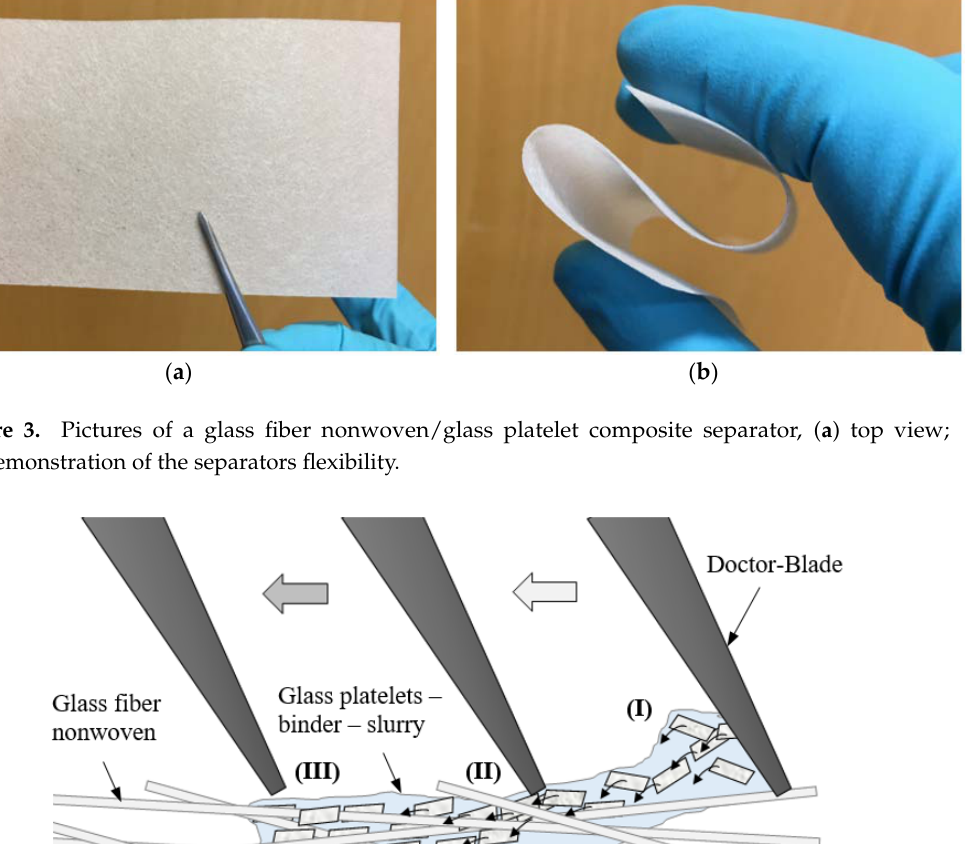
Figure 2. Scanning electron microscopy (SEM) images of a glass fiber nonwoven/glass platelet composite separator, ( a ) top view; ( b ) bottom view.